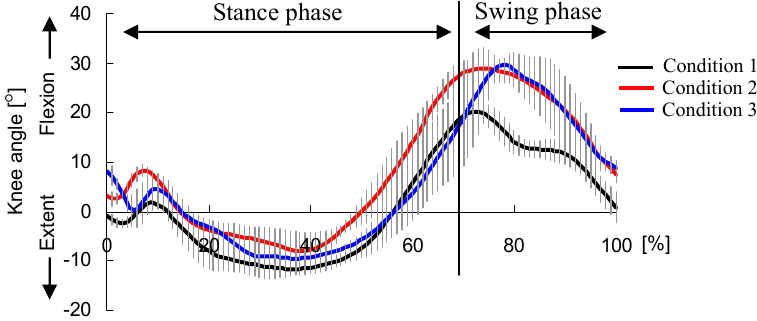
Fig. 8 Joint angle pattern of the affected side knee (mean value ± SD) drawn in the same manner as in Fig. 7.